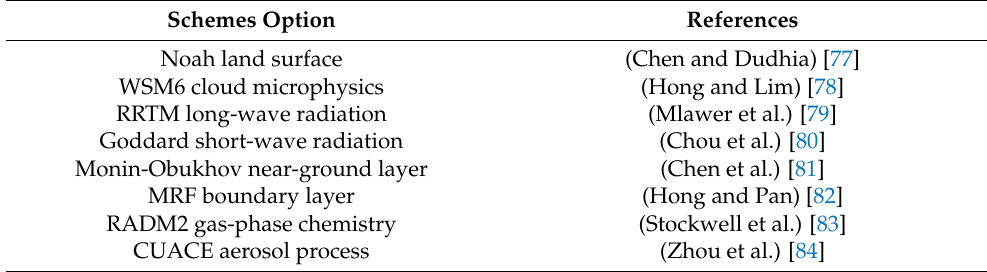
Table 1. Physical and chemical schemes.